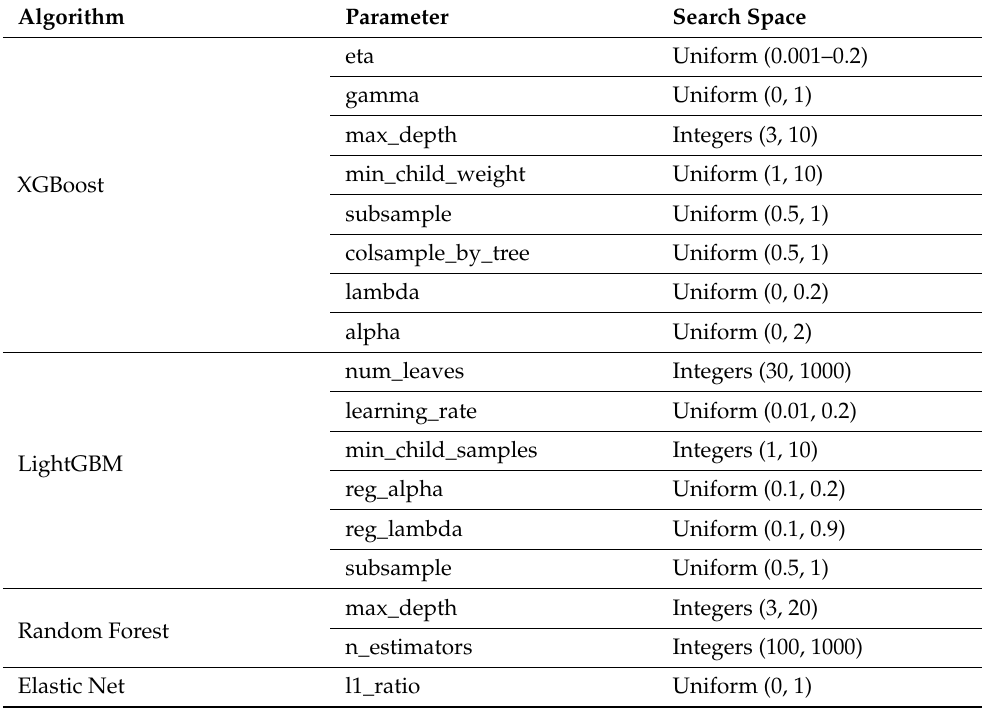
Table A1. Hyperparameter Search Space for Prediction Model